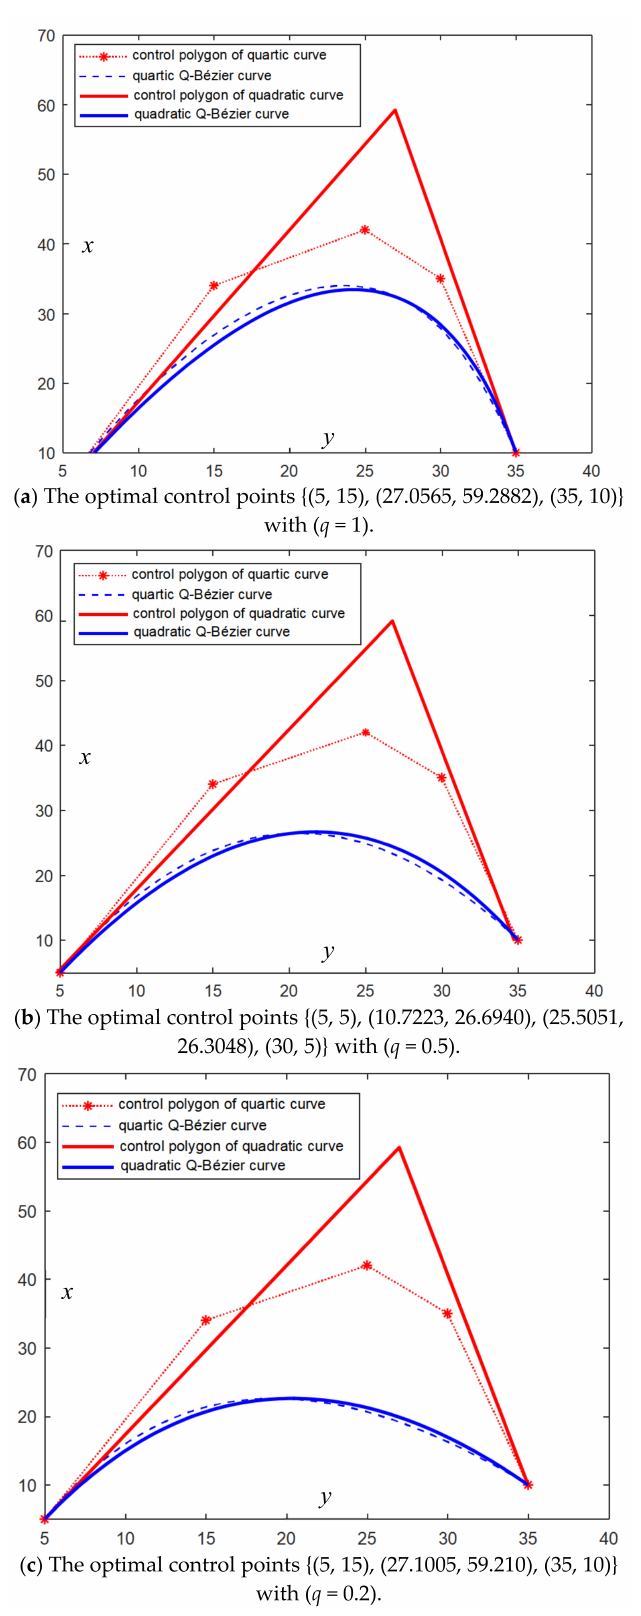
Figure 4. Two-degree reduction of a quartic Q-B é zier curve with the shape parameter q = 1, 0.5,